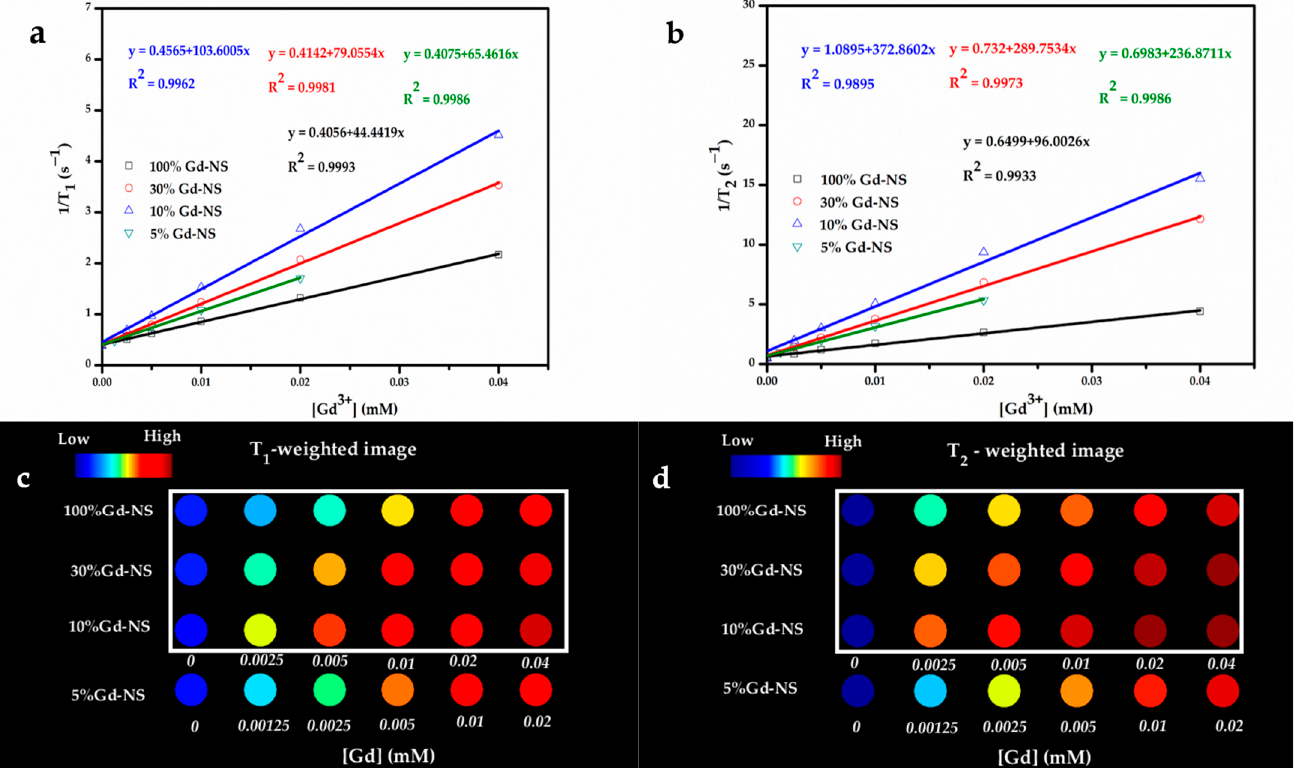
Figure 4. The r 1 ( a ) and r 2 ( b ) relaxivities (mM − 1 s − 1 ) of a series of Gd 3+ -doped LRH-nanosheet sol. Table 1. Summary of magnetite nanoparticles for r 1 and r 2 relaxivity. Reference